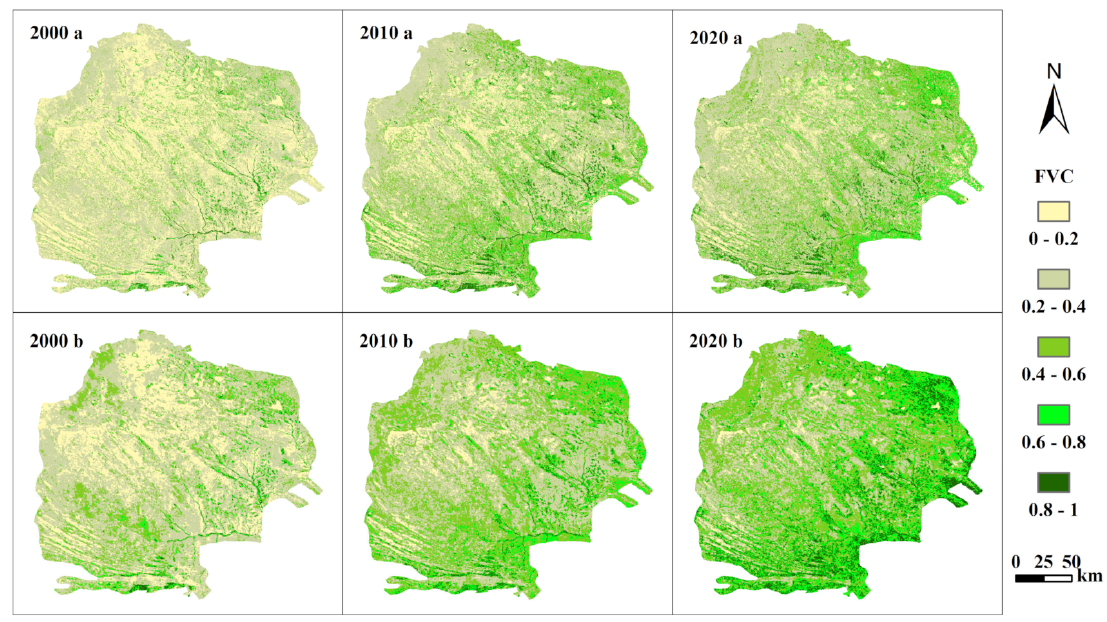
Figure 3. Spatial distribution of the FVC from 2000 to 2020 (a: Landsat, b: